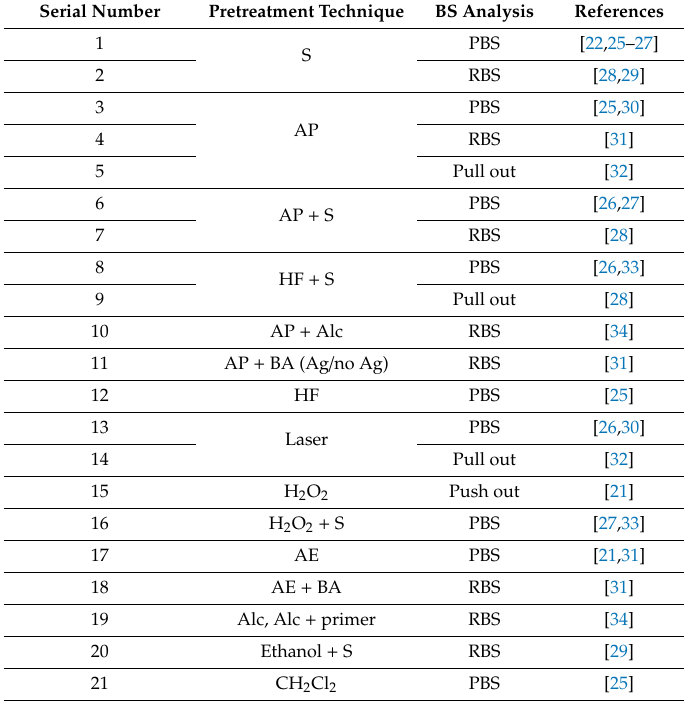
Table 2. Surface treatment strategies done on the fiber-reinforced (FRC)